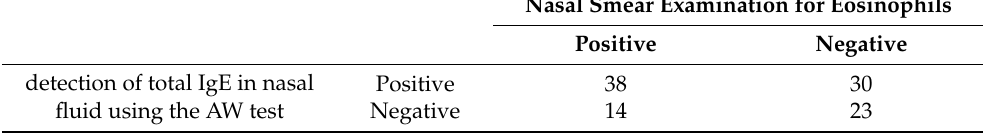
Table 2. Comparison of the sensitivity and specificity for the diagnosis of non-allergic rhinitis (non- AR) between the detection of total IgE in nasal fluid using the AW test and the conventional nasal smear examination for eosinophils.